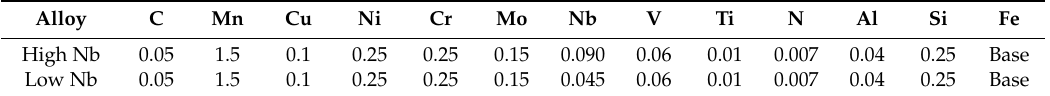
Table 1. Alloys used in this study